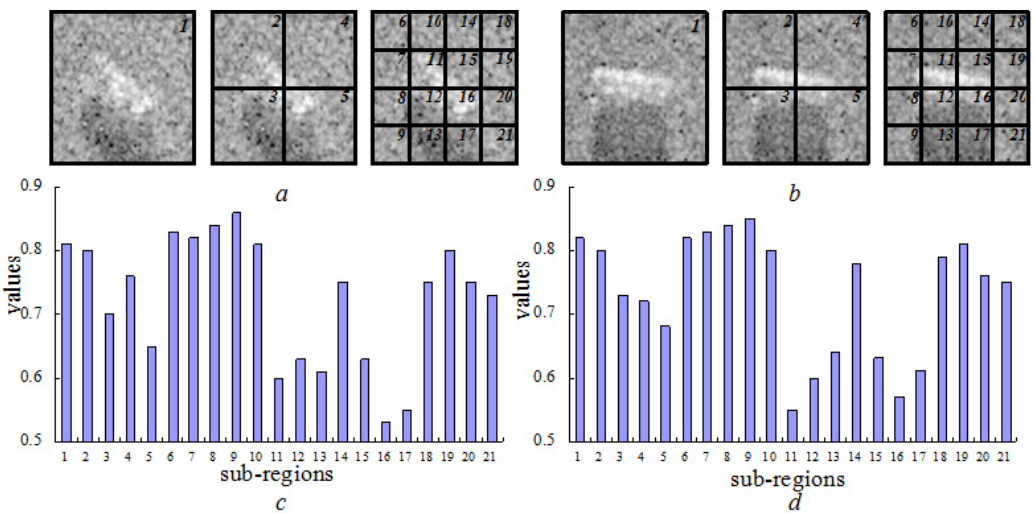
Figure 2. Illustration of the numeric value results of the sub-region sparsity. ( a , b ) are example images illustrating the distribution of sub-regions in the construction of the three-level pyramid. ( c , d ) show the ς k of the sub-regions corresponding to the images ( a , b ).